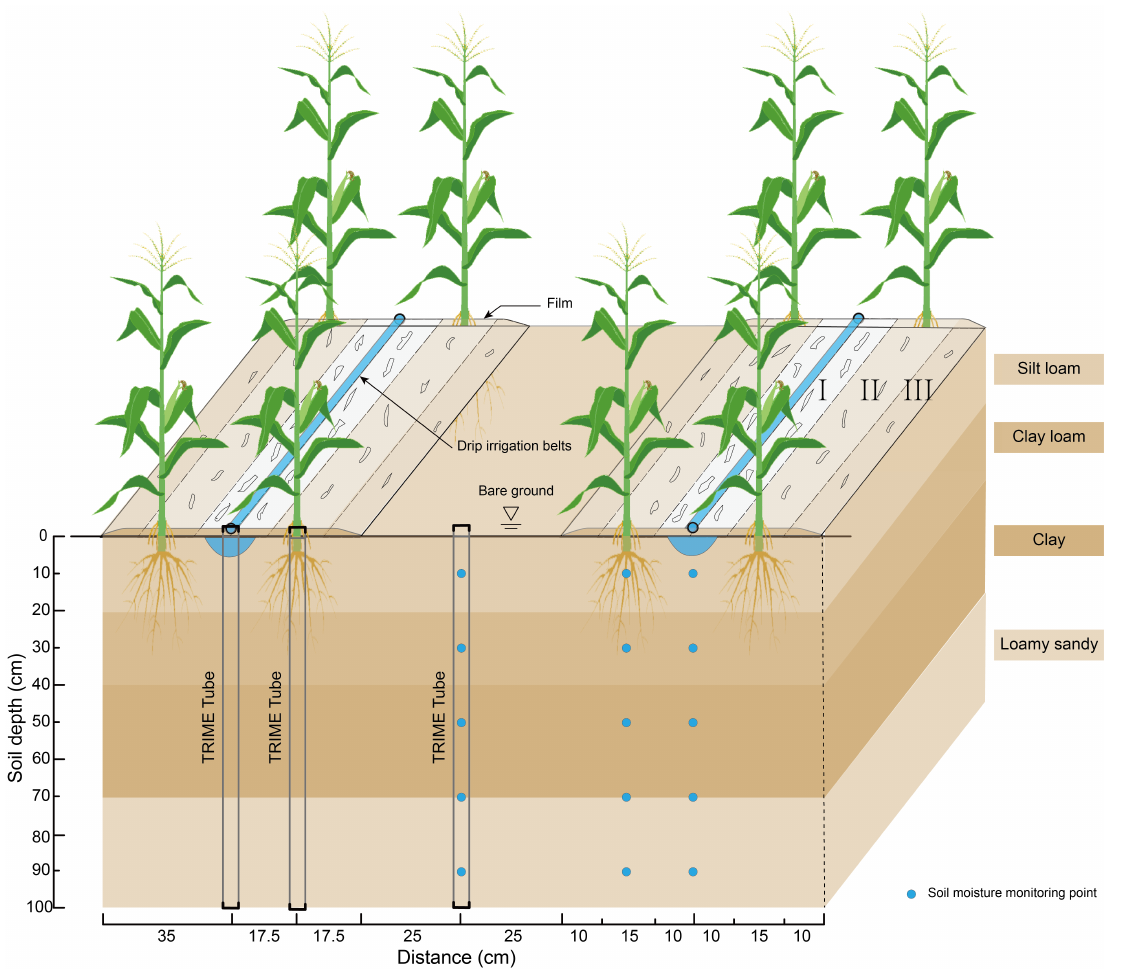
Figure 1. Schematic diagram of planting mode, soil moisture monitoring, and degradation mem- brane